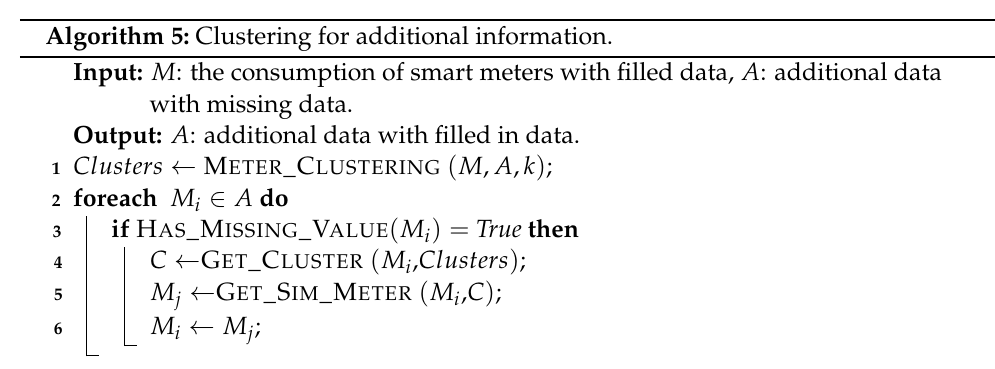
Algorithm 5: Clustering for additional